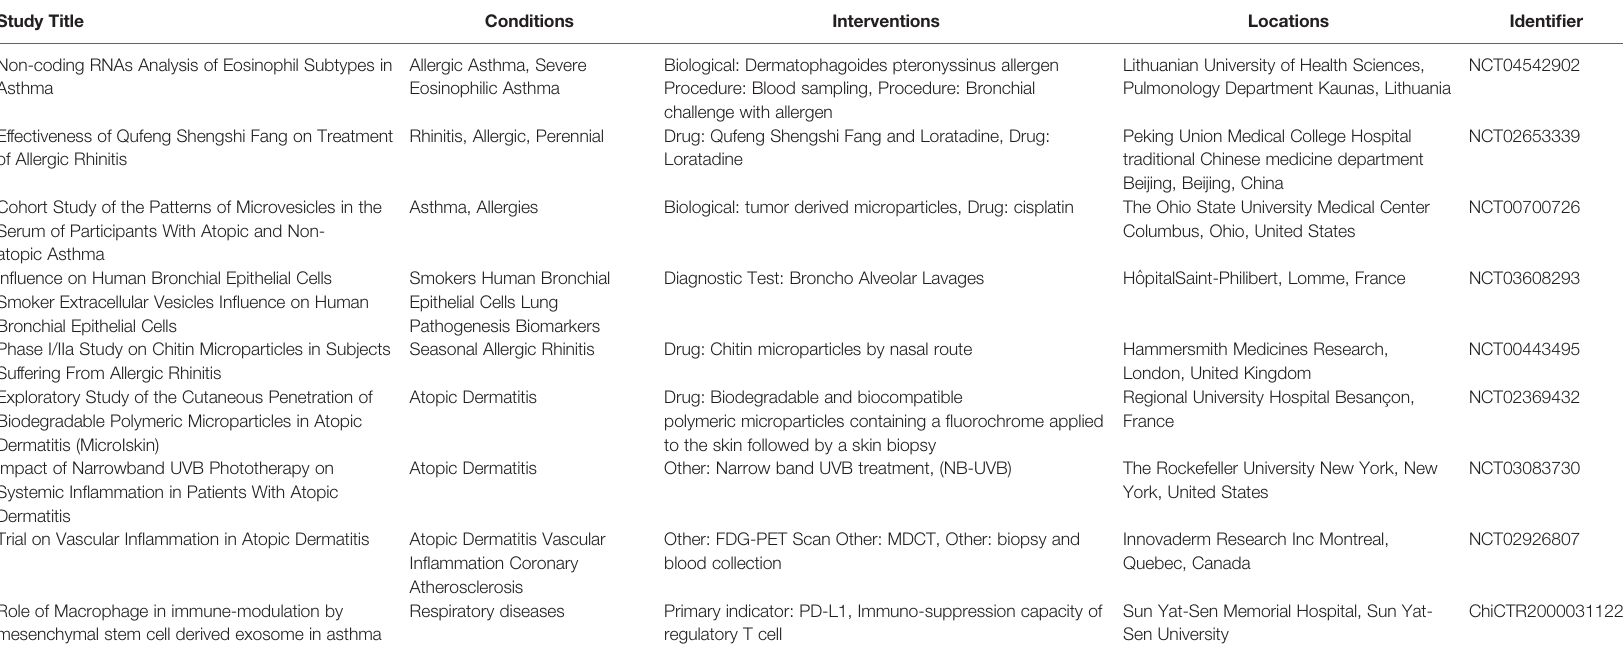
TABLE 3 | Registered clinical trial investigating the feasibility of using EVs in allergic